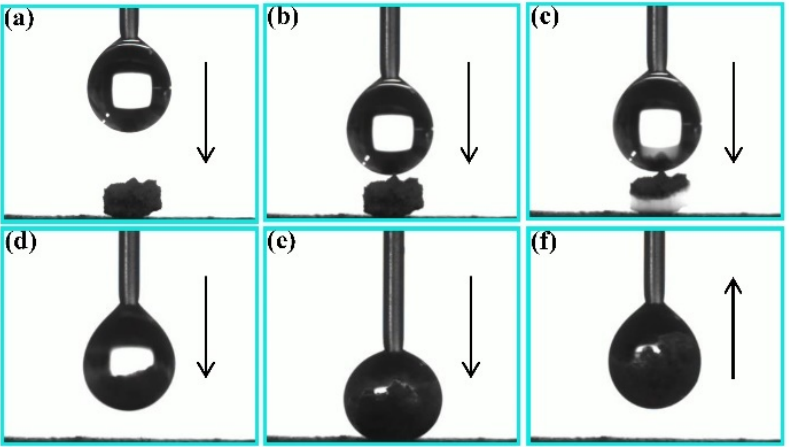
Figure 6. Principle verification of self-cleaning and anti-pollution properties of the CSC coating surface ( a – f ).